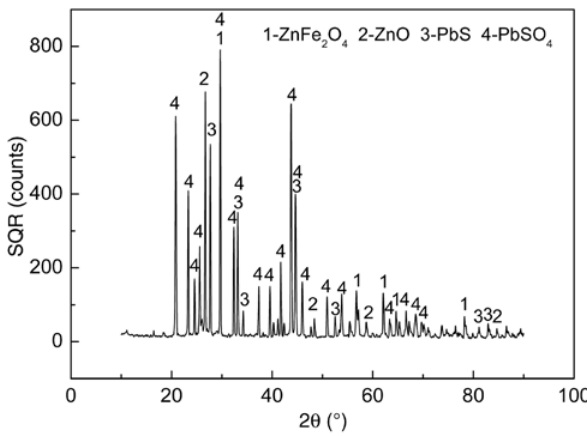
Figure 1: X-ray diffraction (XRD) pattern of zinc oxide leach residues.